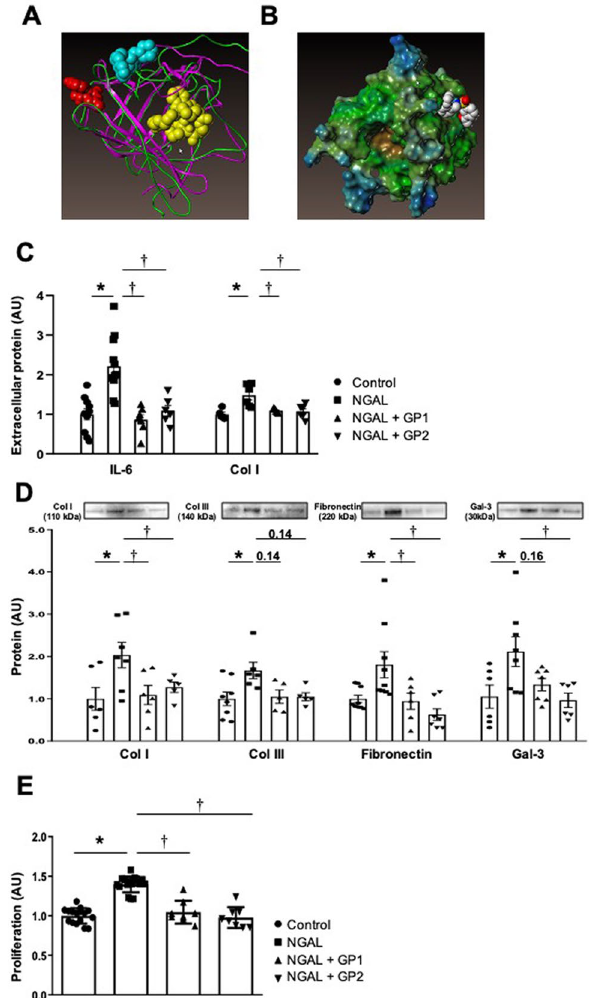
Figure 1. ( A ) Difference in the 3D structure of NGAL as determined by X-rays (1DVF, magenta) and NMR (1NGL, green). The main site is represented by yellow spheres and the two peripheral sites by red and cyan spheres. ( B ) Interaction of GPZ614741 with the NGAL PPI site. Effects of GP1 (GPZ614741) and GP2 (GPZ058225), at 10 µM, on ( C ) IL6 and Col I secretion, ( D ) cellular content of Col I, Col III, fibronectin, and Gal-3, and ( E ) cell proliferation in hNGAL-treated human cardiac fibroblasts. The full-length gel and bands are included in the Supplementary Fig. 10. *p < 0.05 vs. Control. † p < 0.05 vs. NGAL-treated human cardiac